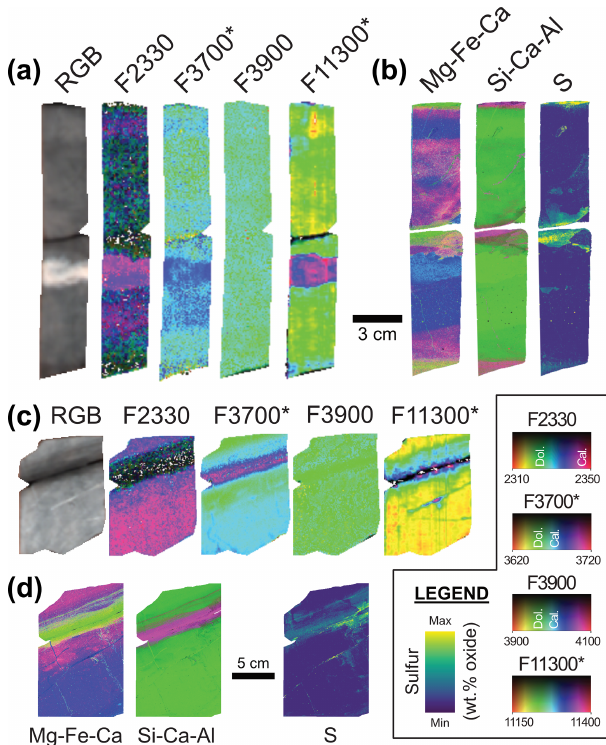
Figure 8. Comparison of hyperspectral imaging (HSI) data and spatially resolved chemical (µXRF) data for validation. (a) HSI data for sample 1 from drill core 136, 1048.7–1048.85m depth, and (b) corresponding µXRF data displayed as false-colour RGB images. (c) HSI data for sample 2 from drill core 136, 1049.4– 1049.5m depth, and (d) corresponding µXRF